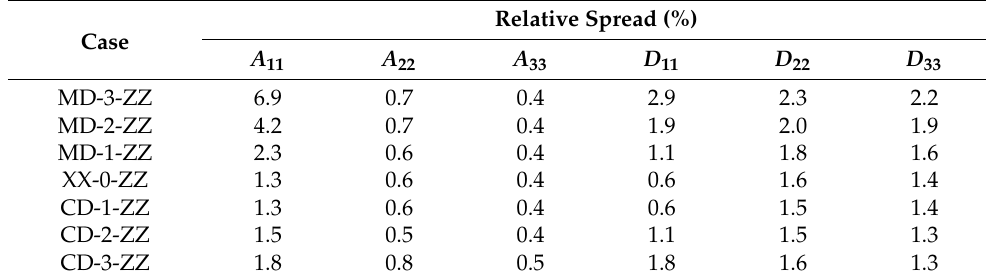
Relative Spread